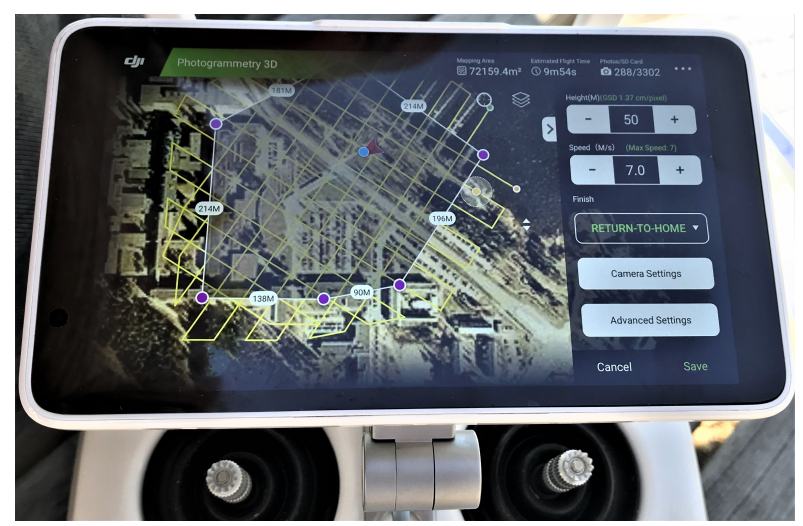
Figure 5. Phantom 4 RTK drone and controller.